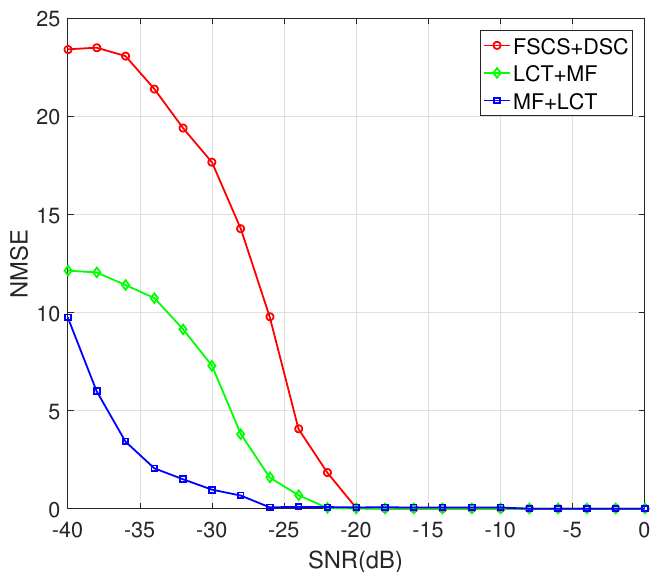
Figure 17. Height estimation performance with different methods.